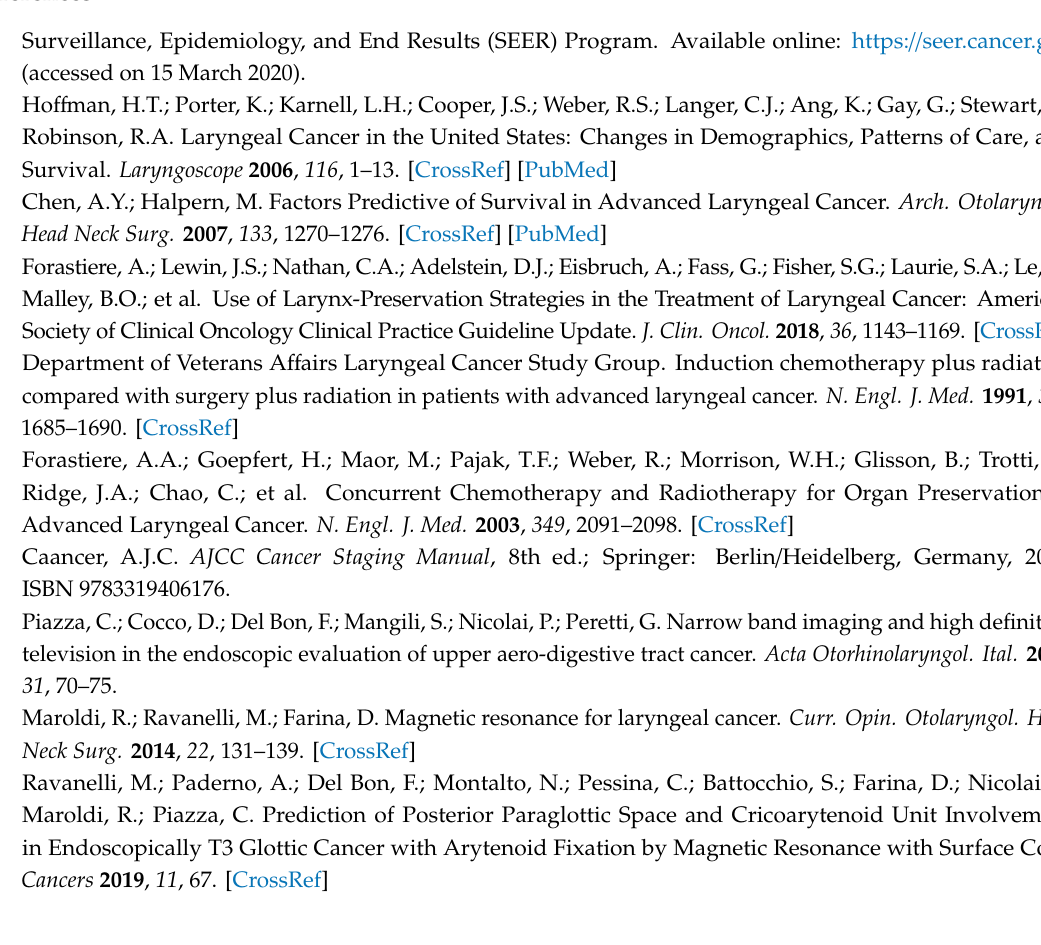
Table S1: Survival estimates at 2 years (2-y) and 5 years (5-y) for main clinical interest covariates. Table S2: Univariable OS and DSS analysis, additional variables. Table S3: Univariable LRRFS and DRFS analysis, additional variables. Figure S1: Kaplan–Meier curves of univariable overall survival (OS) and disease-specific survival (DSS) considering radiologic posterior PGS involvement and arytenoid